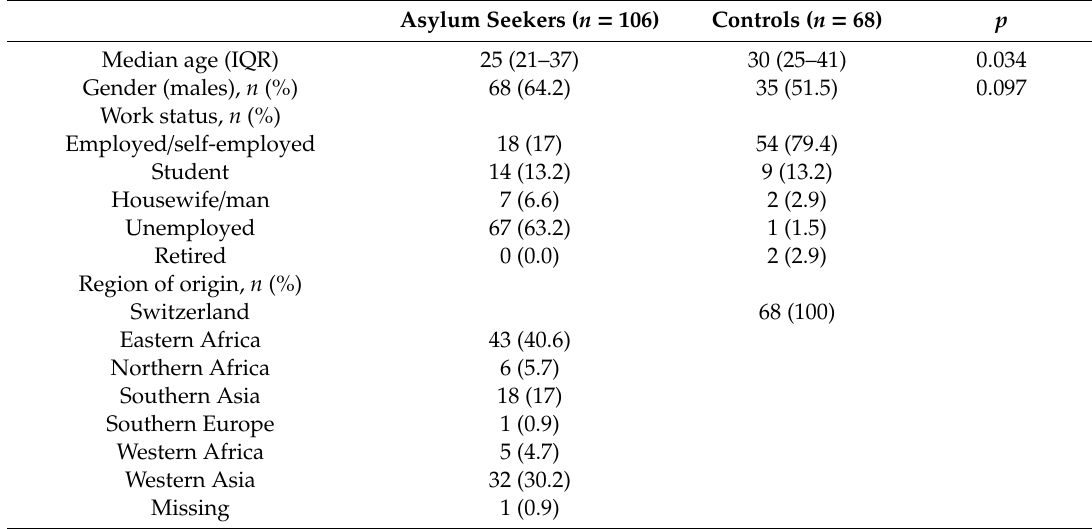
Table 1. Study population demographic